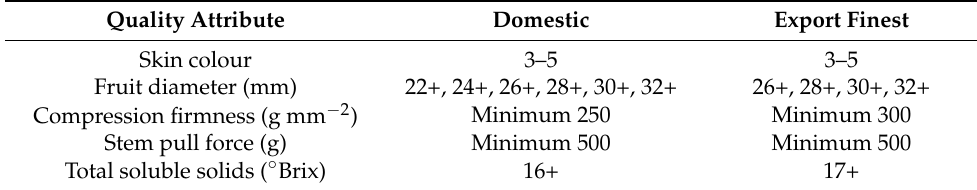
Table 2. Australian industry fruit quality standards for sweet cherry